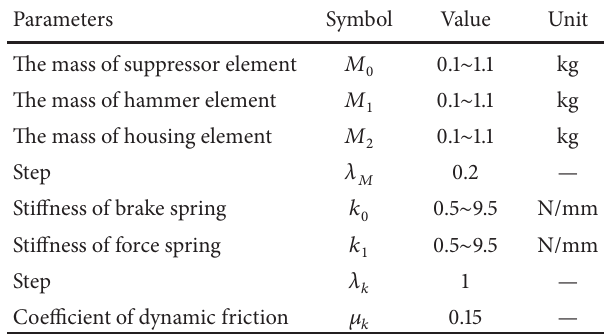
Table 2: Parameters optimization of dynamic model.